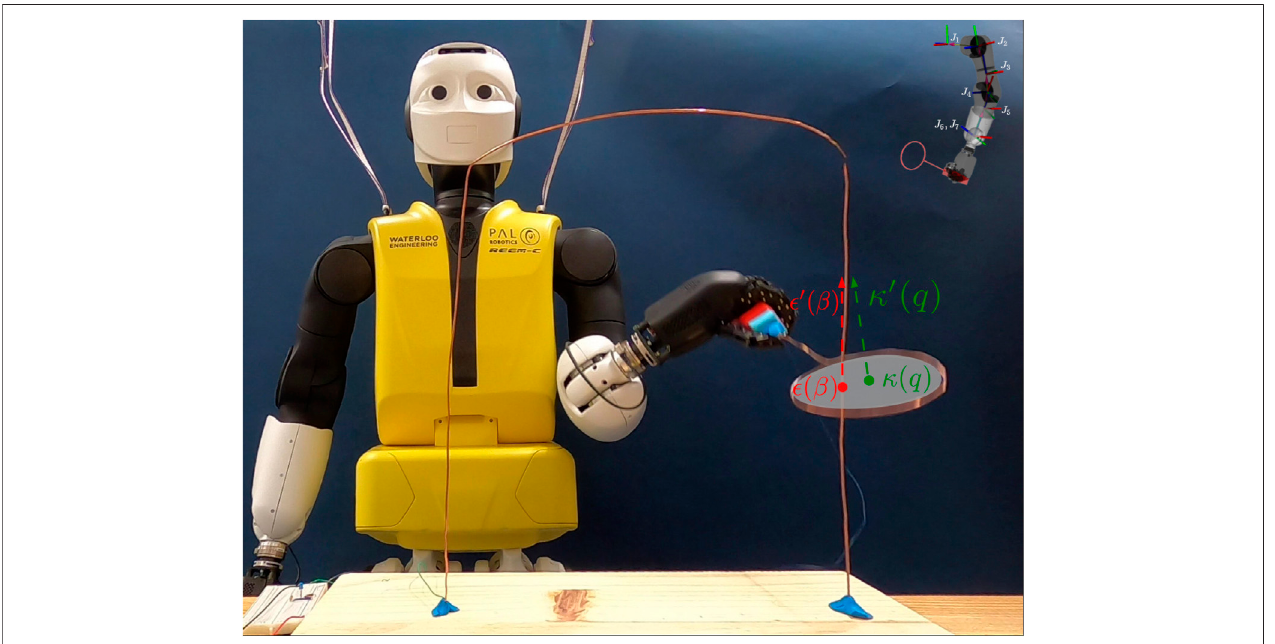
FIGURE1| REEM-Cgrasping theloopend-effectorand movingitalongthebuzzwire obstaclewithanillustration oftheend-effector intersectingtheobstacle.The loop plane circle is in gray, with the centre, κ ( q ), and normal, κ ′ ( q ), in green. The reference point, at position ϵ ( β ), and the tangent, ϵ ′ ( β ) (in red) move along the wire. In the top right corner, the left arm of the REEM-C is pictured with joint axes labelled J 1 through J 7 .